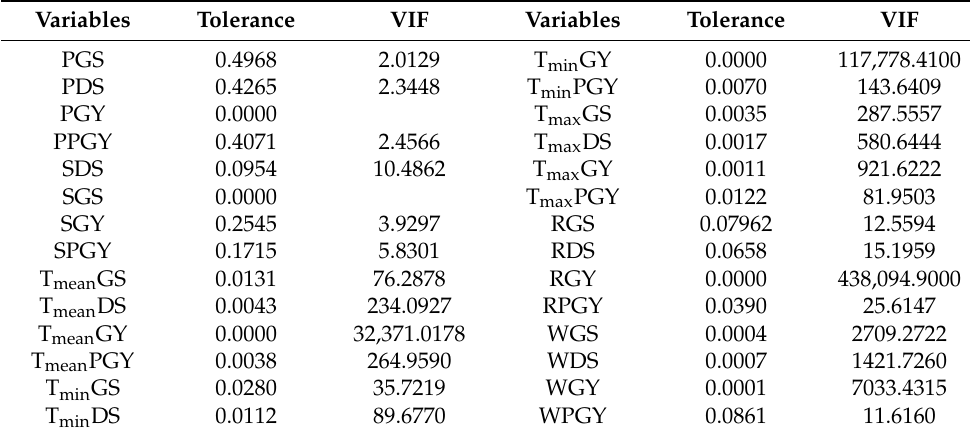
Table 4. Results of multiple collinearity test between climatic